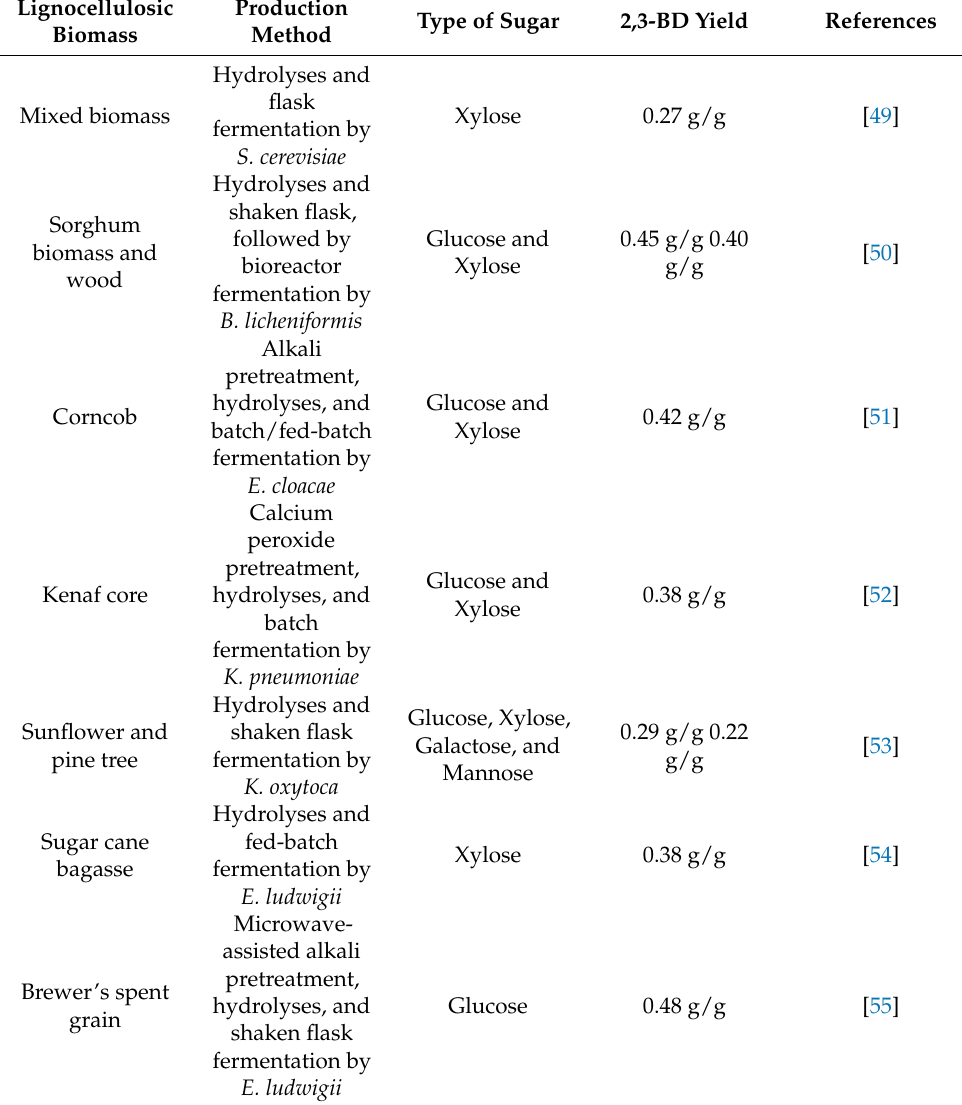
Table 1. Examples of the lignocellulosic biomasses used for 2,3-BD